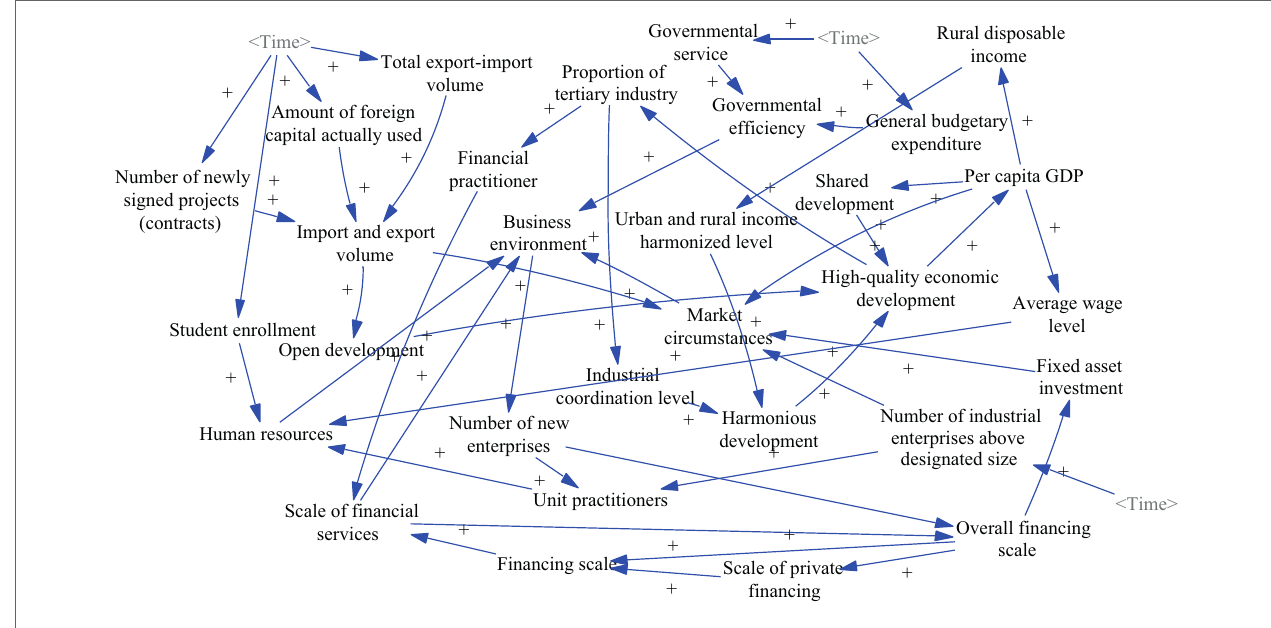
FIGURE 2 | Economic development sub-system causality